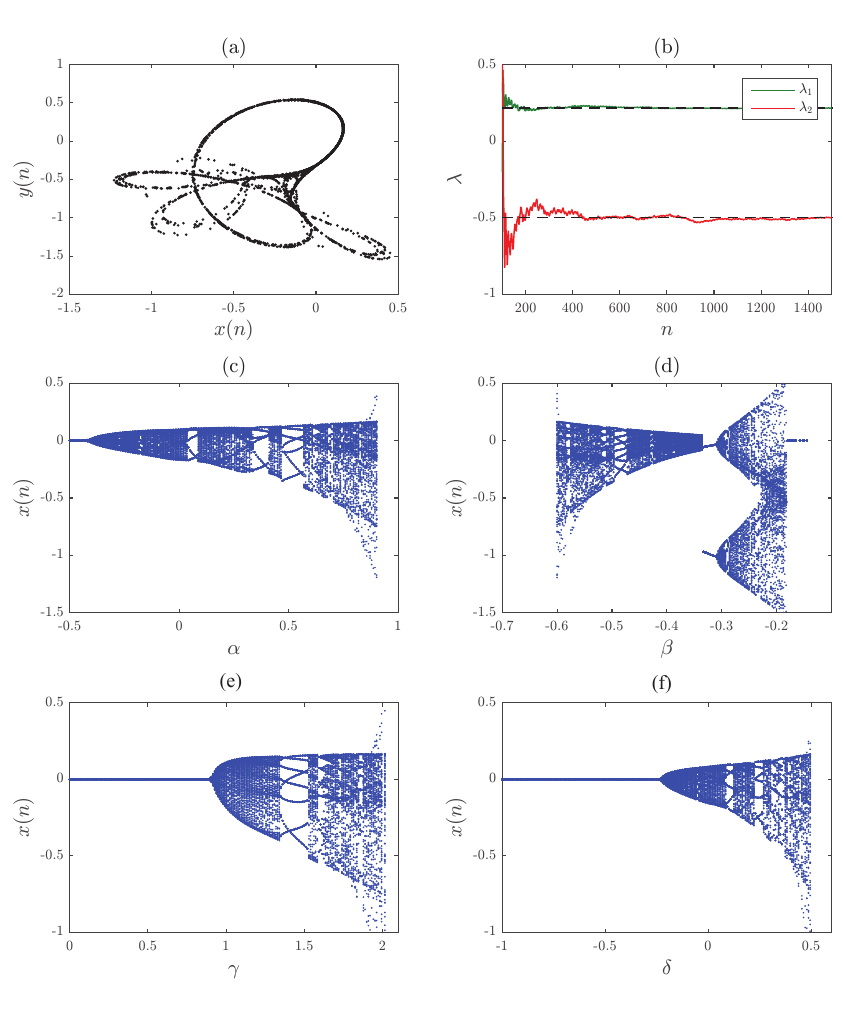
Figure 1. ( a ) Attractor of the Tinkerbell map (2) with ( α , β , γ , δ ) = ( 0.9, − 0.6013,2,0.5 ) and initial conditions ( x ( 0 ) , y ( 0 )) = ( − 0.72, − 0.64 ) . ( b ) Estimated Lyapunov exponents by means of the Jacobian matrix method. ( c ) Bifurcation plot with α ∈ [ − 0.5,1 ] as the critical parameter and ∆ α = 0.0075. ( d ) Bifurcation plot with β ∈ [ − 0.6, − 0.1 ] as the critical parameter and ∆ β = 0.0025. ( e ) Bifurcation plot with γ ∈ [ 0,2.1 ] as the critical parameter and ∆ γ = 0.01. ( f ) Bifurcation plot with δ ∈ [ − 1,0.6 ] as the critical parameter and ∆ δ =